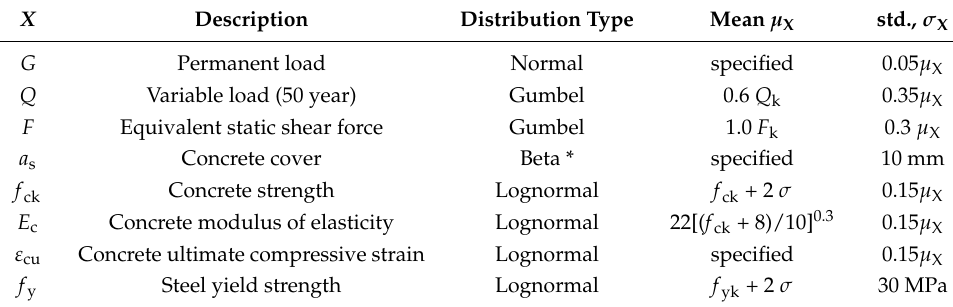
Table 1. Uncertainty characterization of random